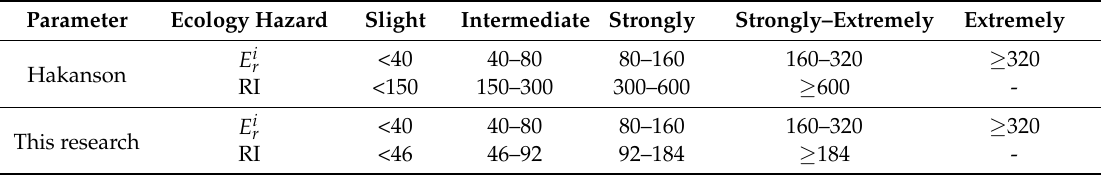
Table 1. The classification of potential ecology